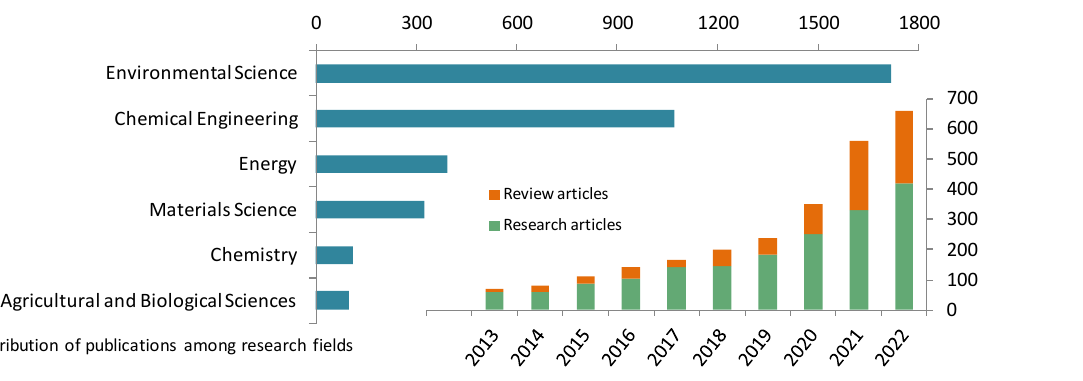
Figure 1. Research and review articles on the topic “Chromium-containing wastewater”. Data source: https://www.sciencedirect.com/ (accessed on 30 November 2022).